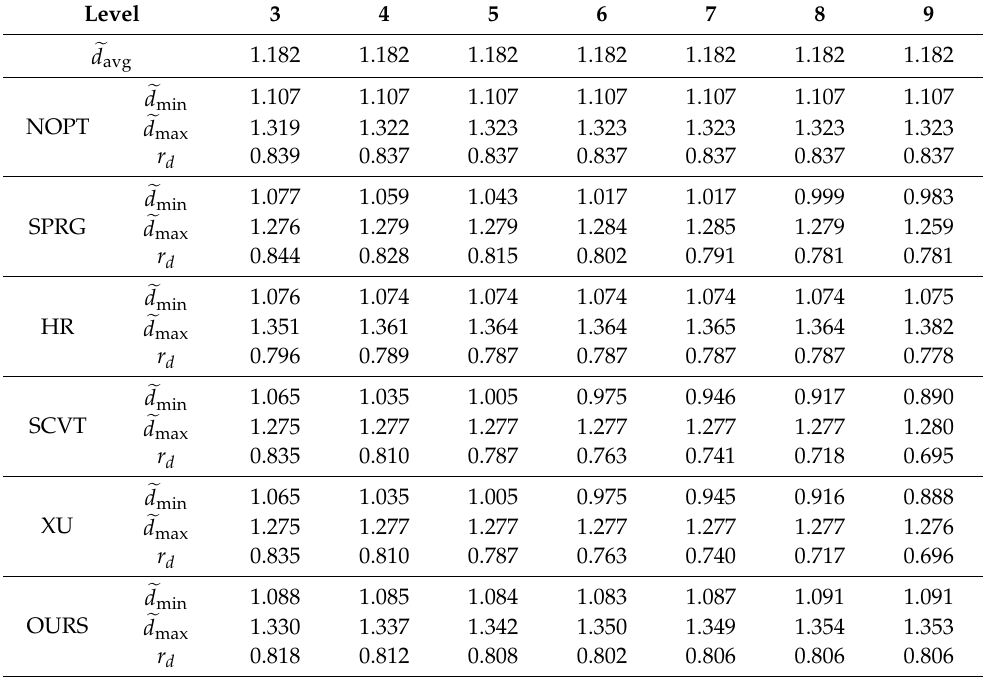
Table 7. Normalized distance and ratios between the d min and d max of different grids.